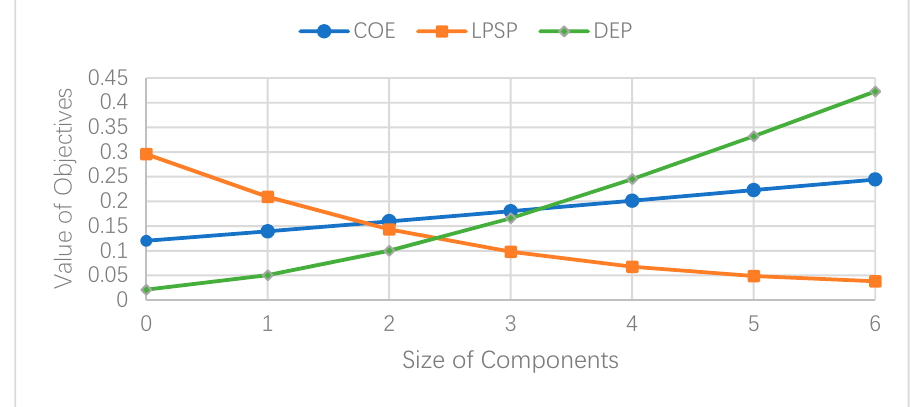
Figure 19. Sensitivity analysis results of TCTs.